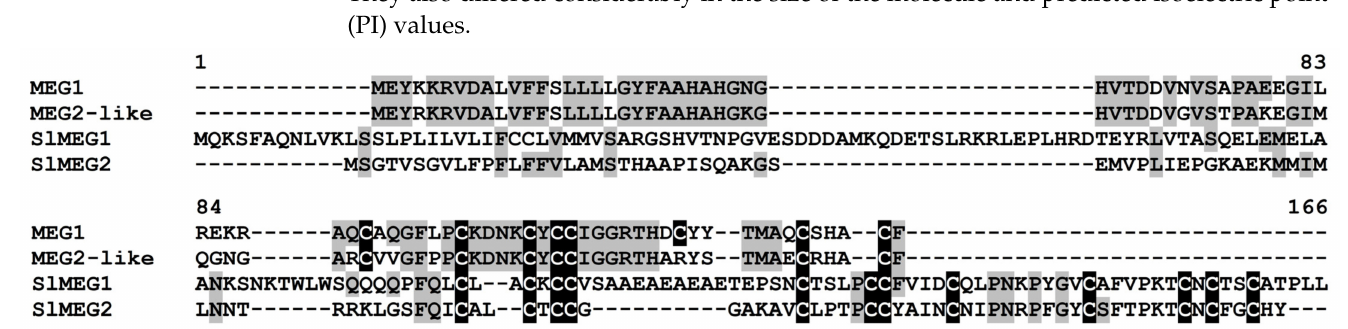
Figure 12. Multiple sequence alignment of S. lycopersicum MEG precursors and Zea mays MEG1 (XP_008652138.1), MEG2-like (XP_020397032.1). Cysteine residues are shaded black, and identical amino acids are shaded gray.